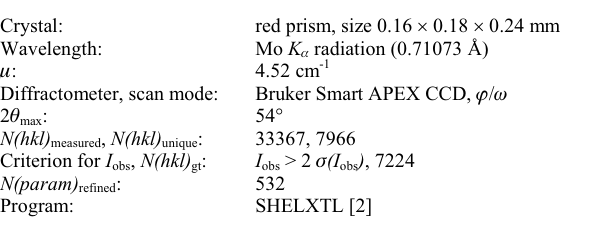
Table 1. Data collection and handling.